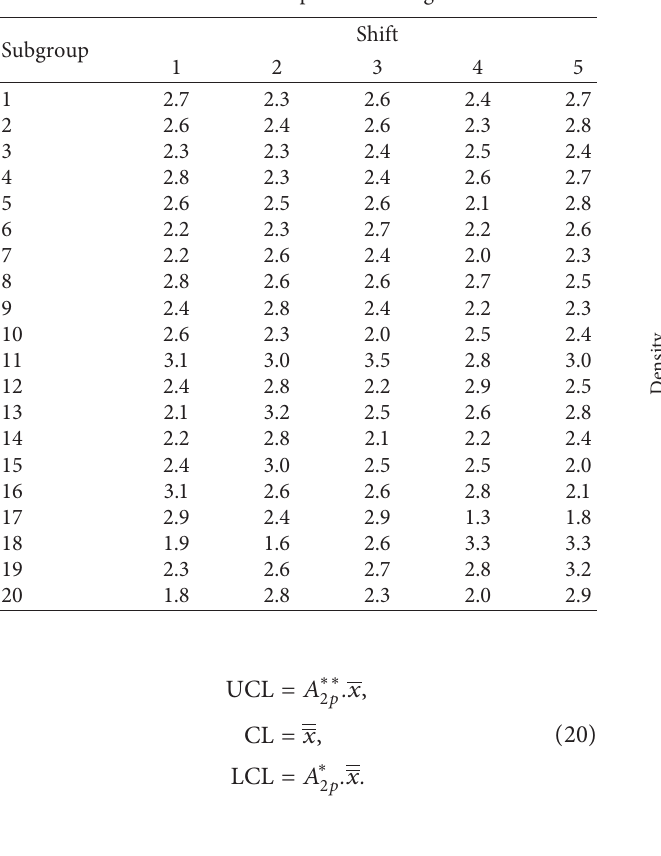
Table 3: Thickness of paint on refrigerators.